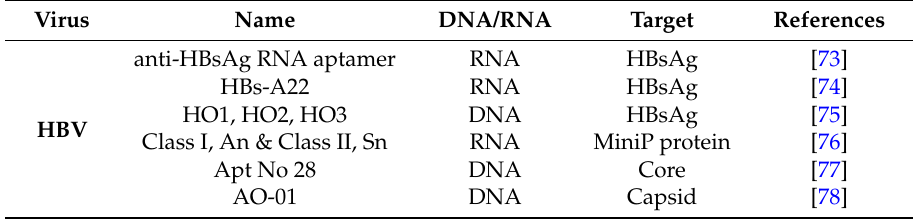
Table 3. Summary data on the aptamers selected against HBV discussed